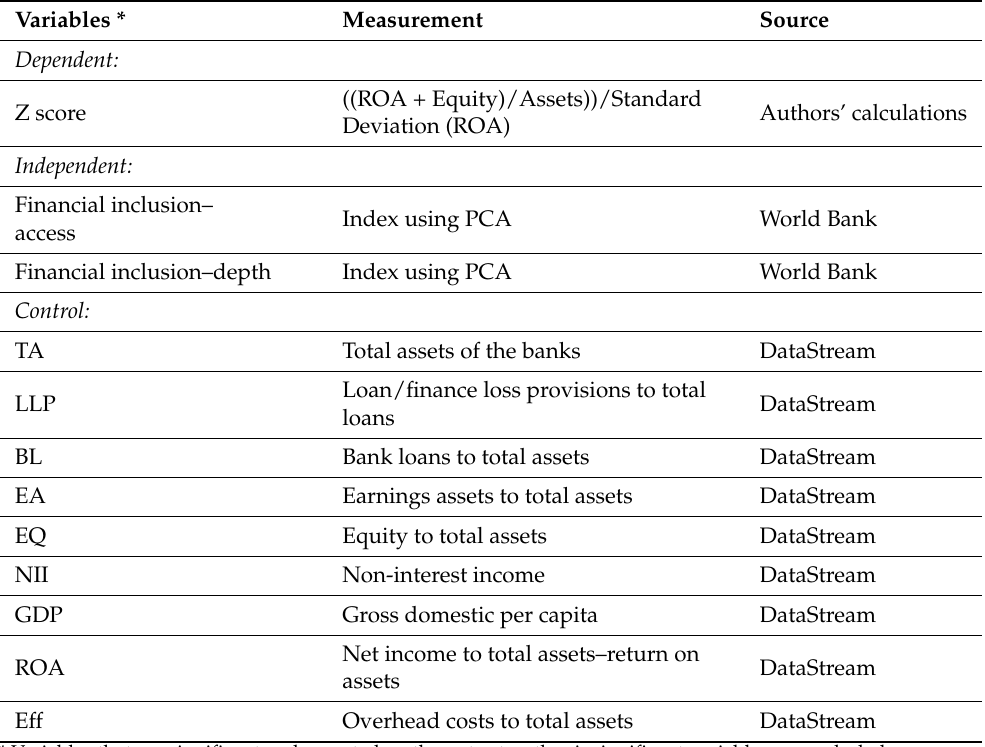
Table 2. Variables definition and